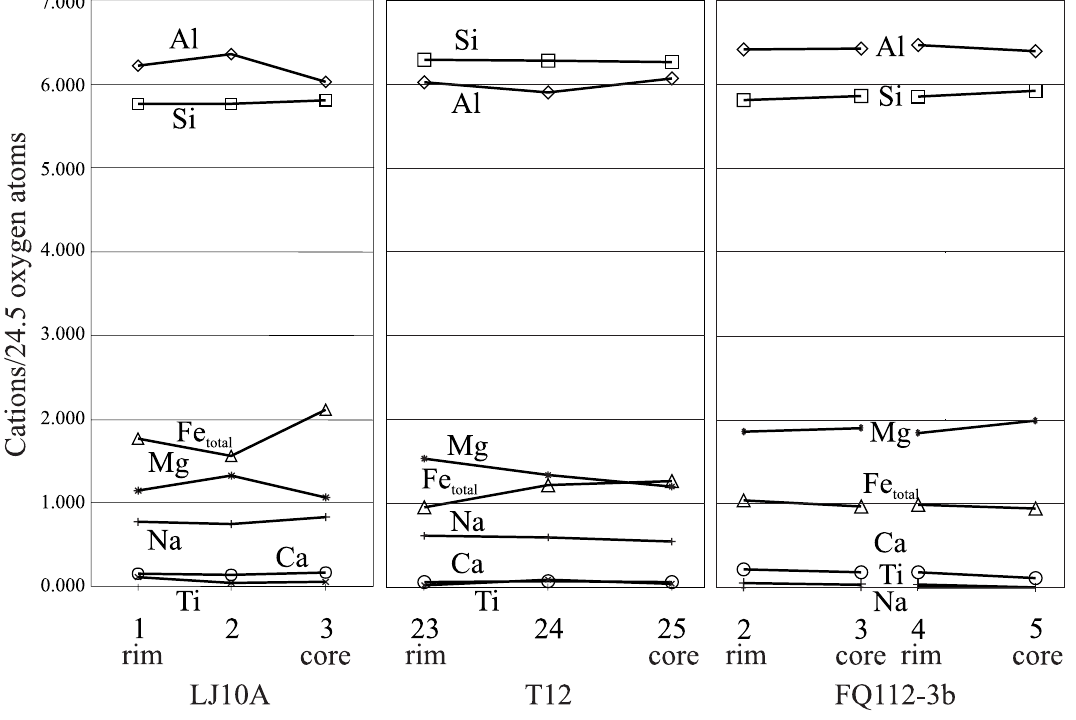
Fig. 6 – Variations of number of atoms per formula unit (apfu) from rim to core of tourmaline crystals in metachert (LJ10A – Tapera Grande), tourmalinite (T12 – Tapera Grande) and quartz vein (FQ112-3b –